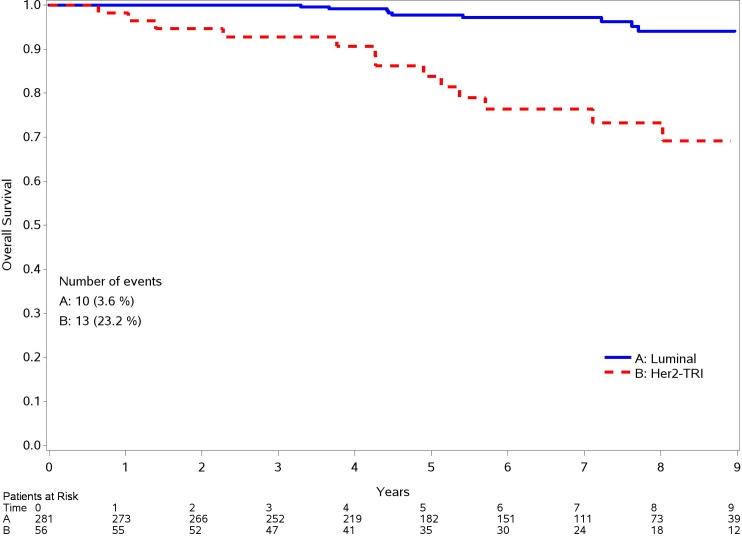
OS for different molecular subtype.